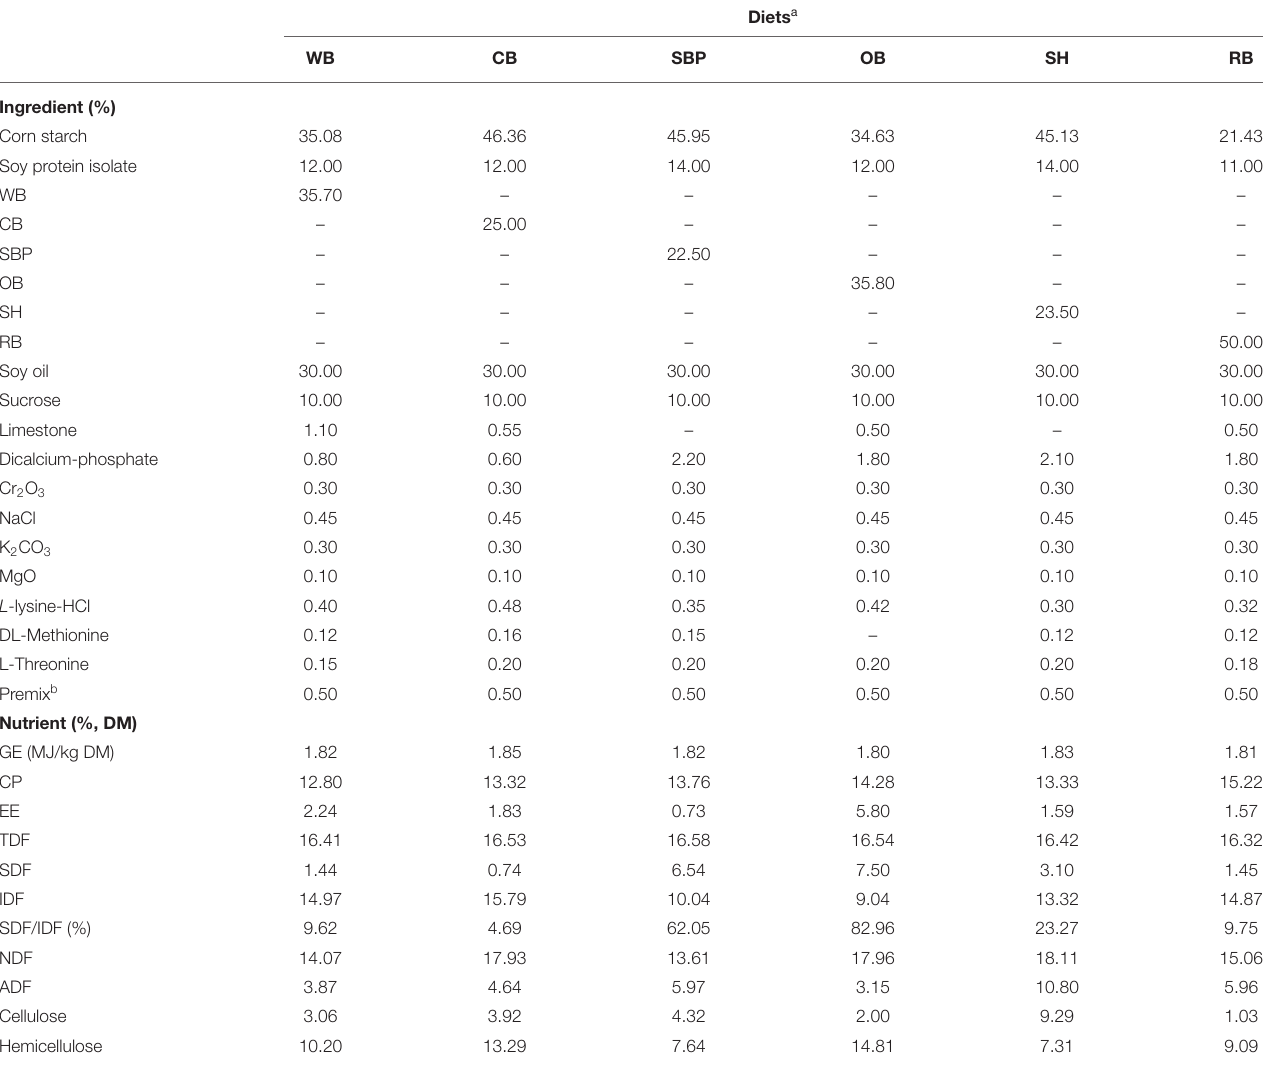
TABLE 1 | Ingredients and nutrient compositions of the